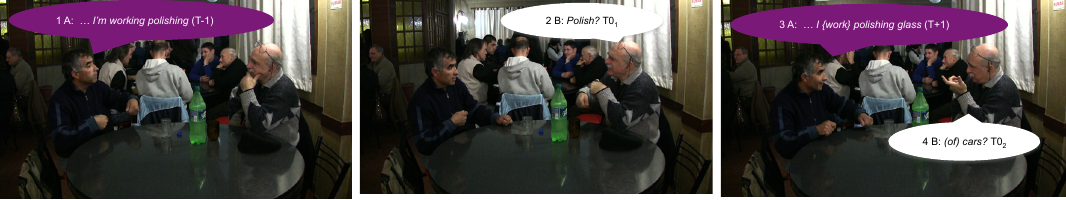
Figure 26. ‘{of} cars?’, Person B initia- tes a second repair by offering a can- didate understanding in combination with his eyebrows raised (line